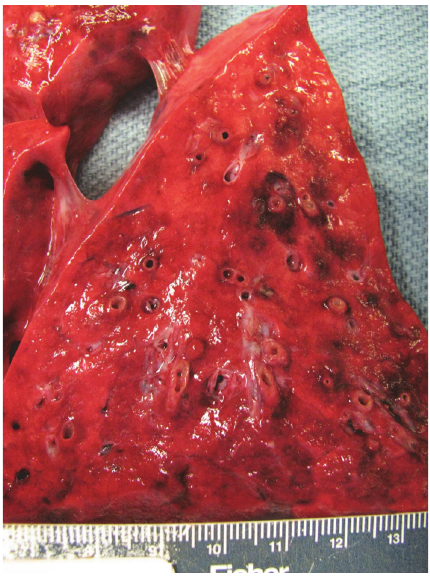
Figure 5: Autopsy: coronal cut through lung demonstrating peri- bronchial congestion and hemorrhage.